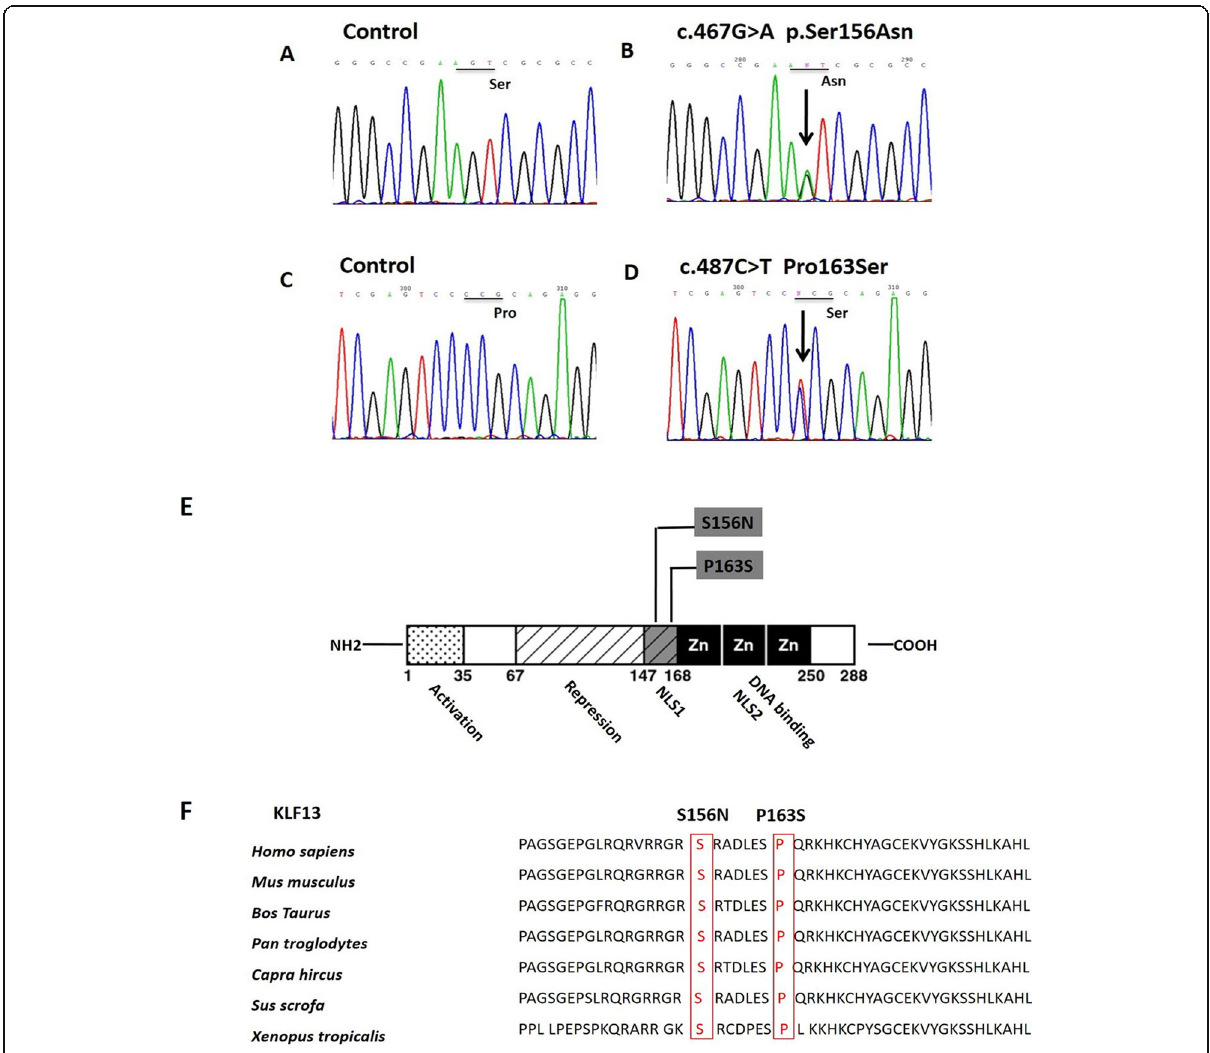
Fig. 1 Sequence chromatograms of KLF13 missense variants in patients and controls. a and c : Chromatograms of normal controls. b and d : Chromatograms of the three heterozygous variants. Arrows show heterozygous nucleotide changes; e : Location of the KLF13 variants (highlighted in bold). NLS, nuclear-localization signals; Zn, zinc finger domain. f : Alignments of KLF13 protein among different species indicated that S156N and P163S were conserved among vertebrates